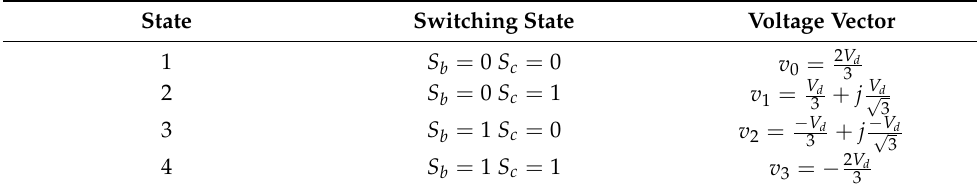
Table 4. Switching States and Voltage